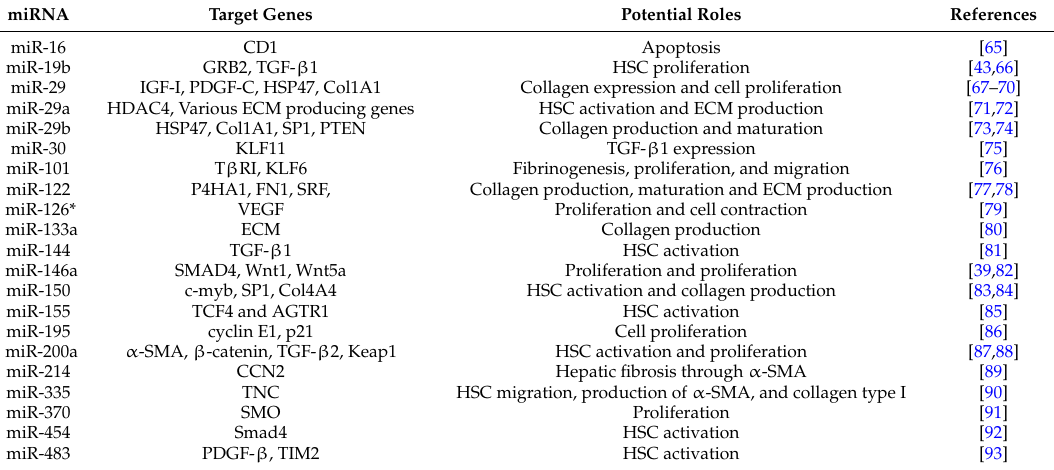
Table 3. Down-regulated miRNAs in activated hepatic stellate